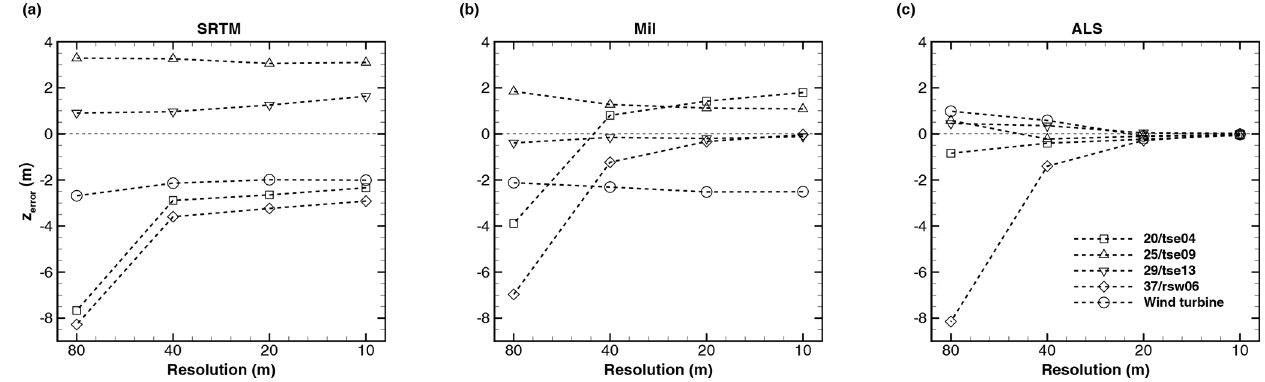
Figure 6. Impact of mesh resolution on reference points: (a) SRTM, (b) Mil, (c) ALS.